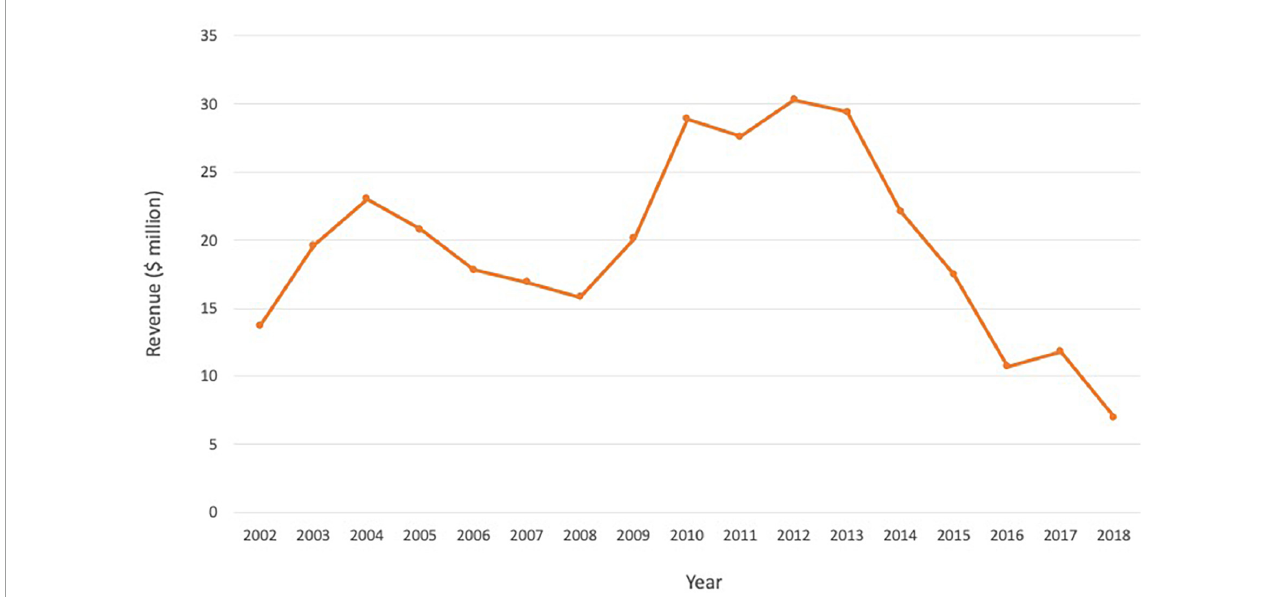
FIGURE2 Annual revenue for Zevalin over the period 2002–2018, reflecting a steady decline and failure to meet forecasts. Source: Biogen and Spectrum financial